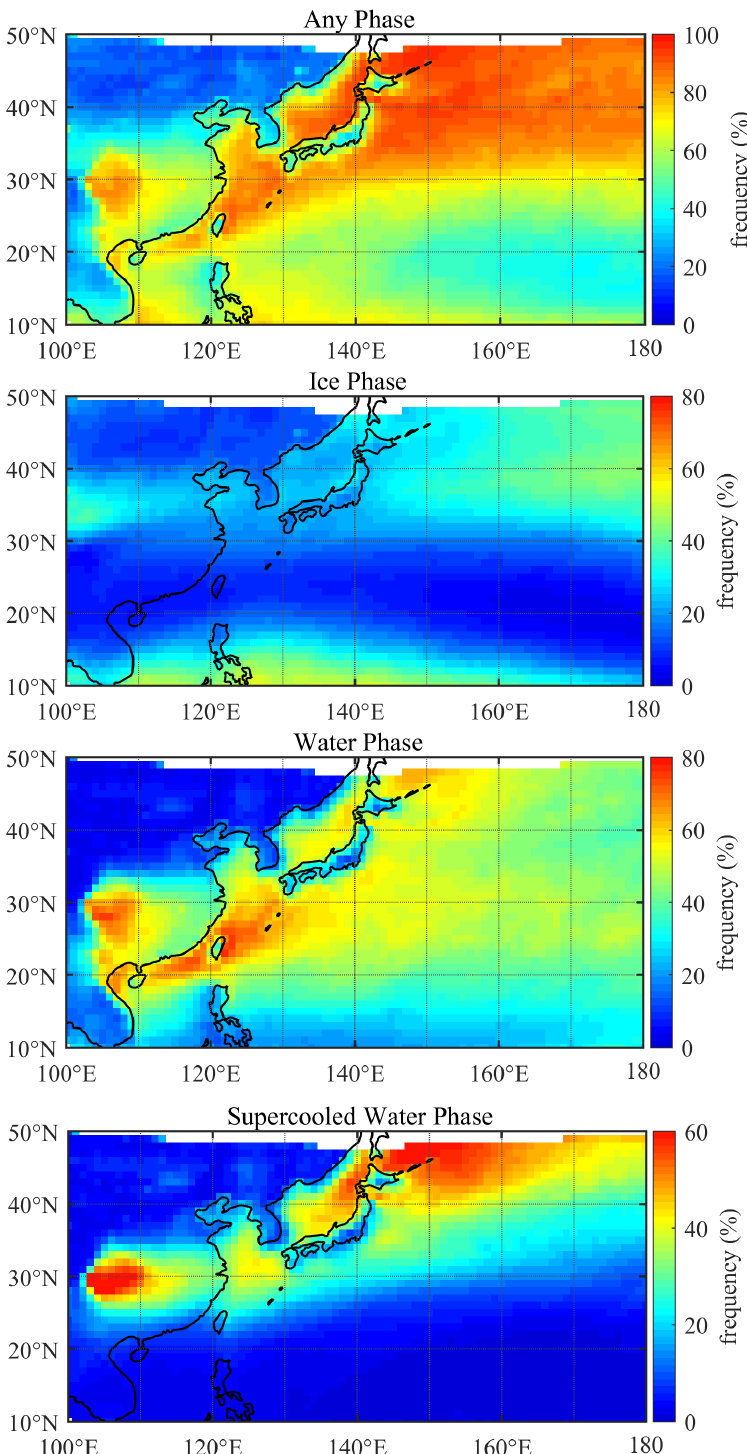
Figure 4. The 1° × 1° gridded seasonally averaged frequency (unit: %) distributions of cloud-top phases using the 3-year boreal summer data.